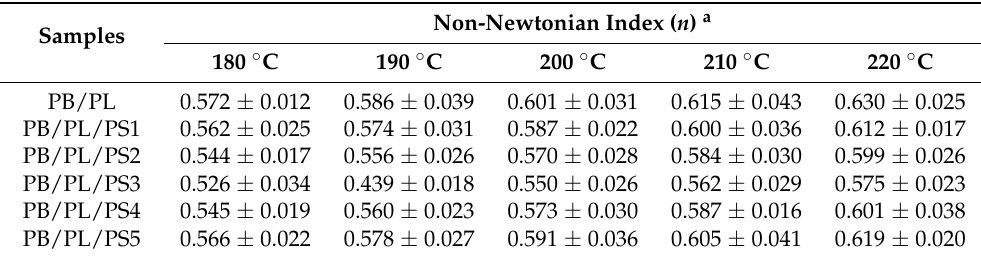
Table 5. Data for the non-Newtonian indices of PBST/PLA blends with various amounts of PSMA under different